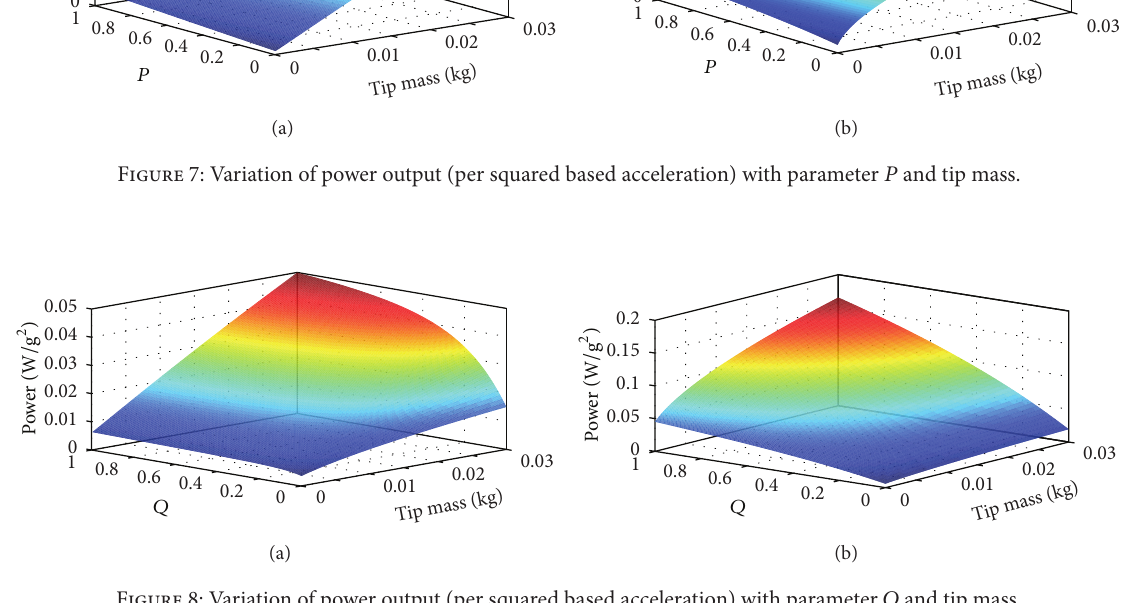
Figure 8: Variation of power output (per squared based acceleration) with parameter 𝑄 and tip